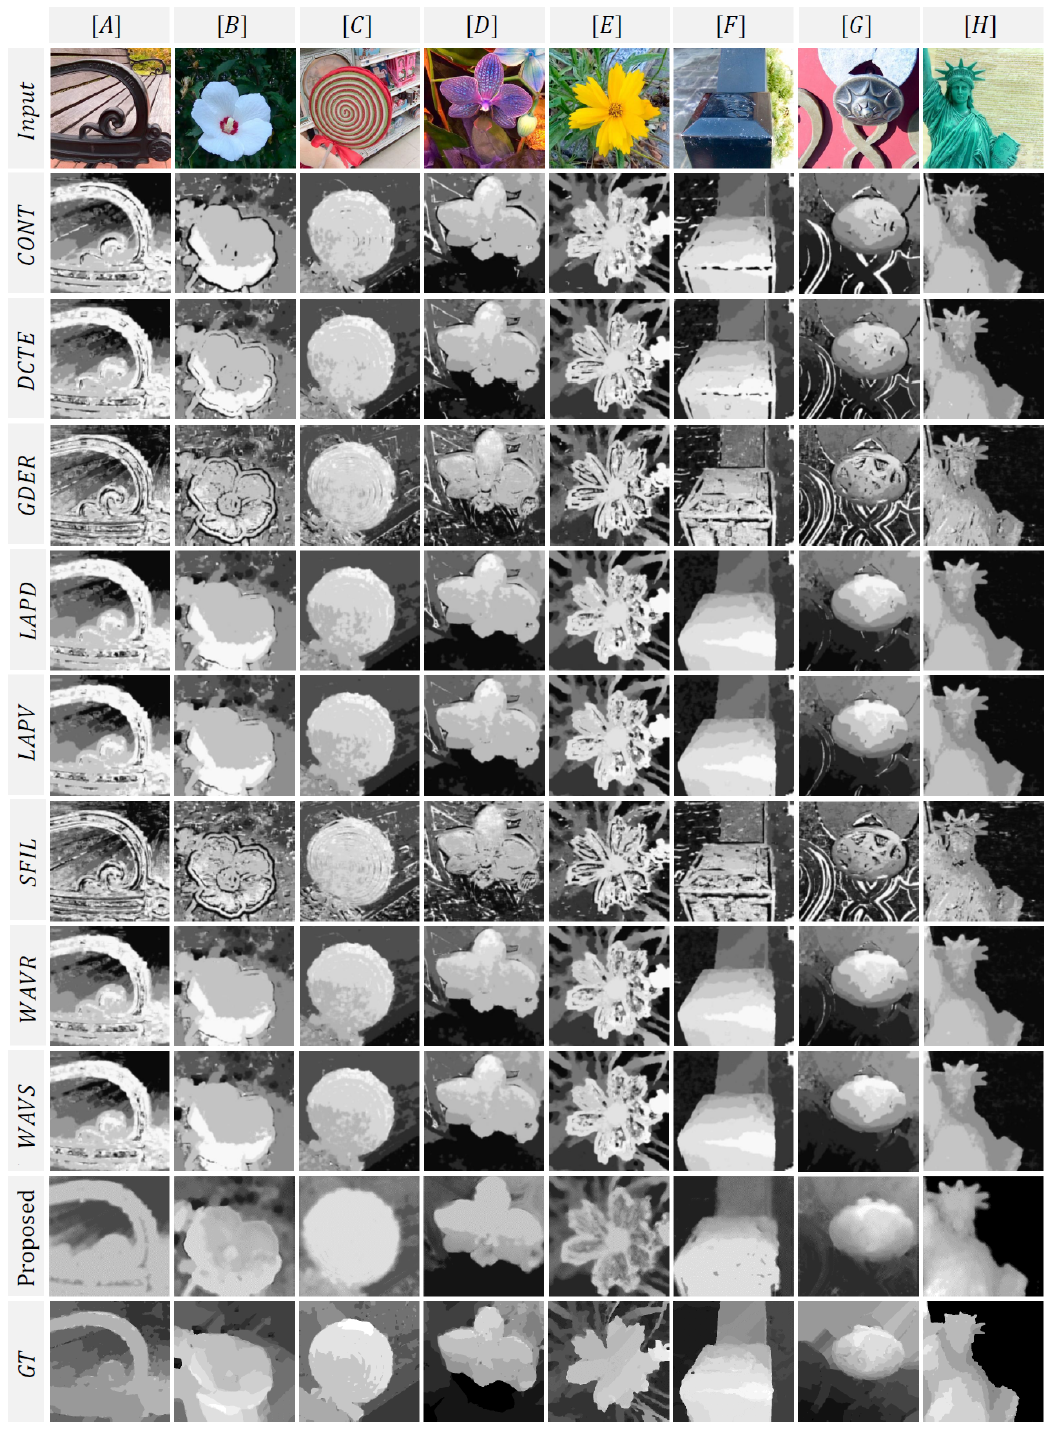
Figure 11. Experimental results on the LFSD dataset [28]. ( A )—bench (6-frames), ( B )—flower (10), ( C )—lollipop-toy (7), ( D )—flower-2 (9), ( E )—flower-3 (12), ( F )—marble-stone (12), ( G )—door-handle (12), and ( H )—liberty statue (10). The first row shows all in focus images, 2–9 rows are results from previous focus measuring and state-of-the-art DFF methods, 10-rows show reconstructed depth maps of our proposed method, and last row shows show given depth from Reference